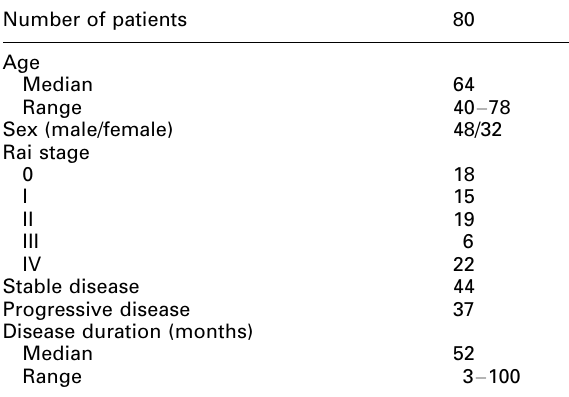
Table 1. Patient characteristics Number of